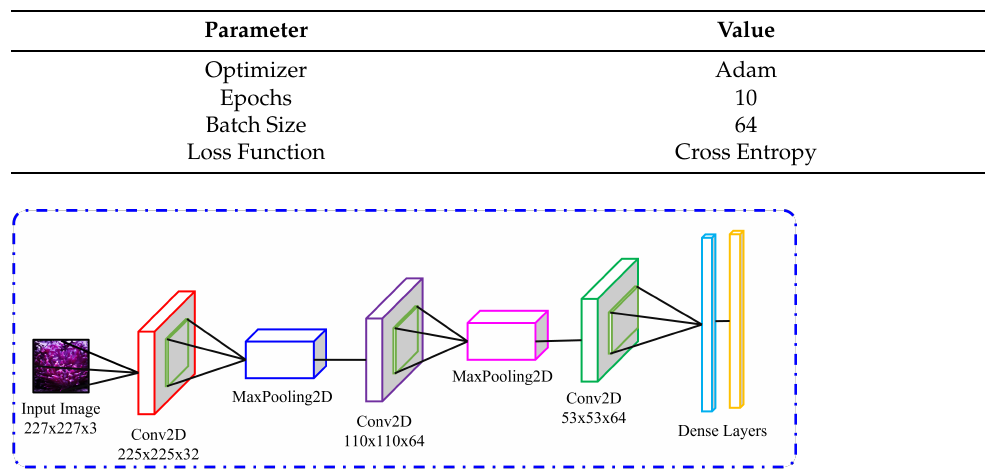
Figure 6. Feature Extraction with